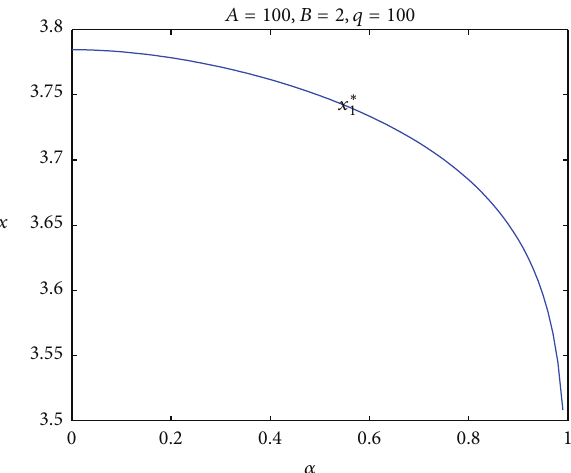
Figure 2: Optimal wholesale prices 𝑥 ∗ 1 for different confidence level 𝛼